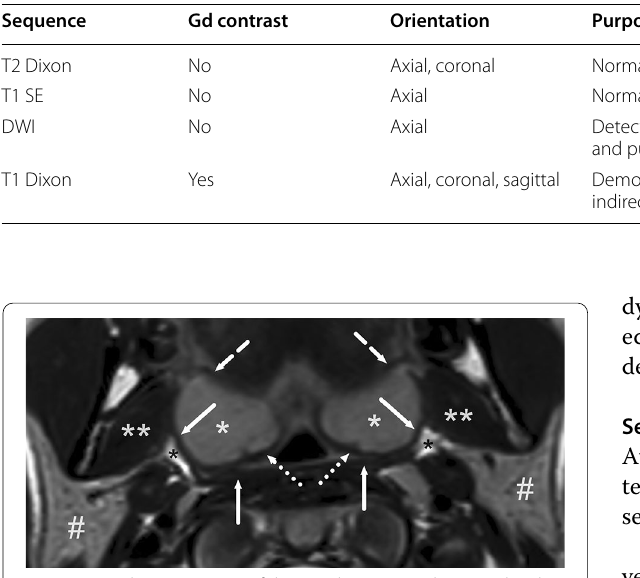
Fig. 2 Normal MRI anatomy of the oropharynx. Axial T2-weighted image shows the palatine tonsils (white asterisk) bounded laterally by the superior constrictor muscle (arrow), anteriorly by the palatoglossus muscle (dashed arrow), and posteriorly by the palatopharyngeus muscle (dotted arrow). Posterolateral to the superior constrictor muscle and the buccopharyngeal fascia is the parapharyngeal space indicated by fat signal (black asterisk). The medial pterygoid muscle (double white asterisk) and the parotid gland (hash) can be seen in the masticator and parotid spaces, respectively